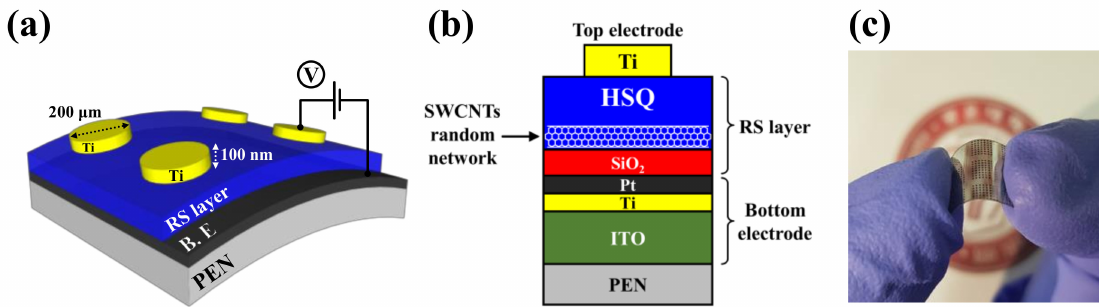
Figure 1. Hydrogen silsesquioxane (HSQ) memristor with an embedded single-walled carbon nanotube (SWCNT) random network fabricated on a flexible polyethylene naphthalate (PEN) substrate: ( a ) schematic diagram, ( b ) cross-sectional detail, and ( c ) photographic